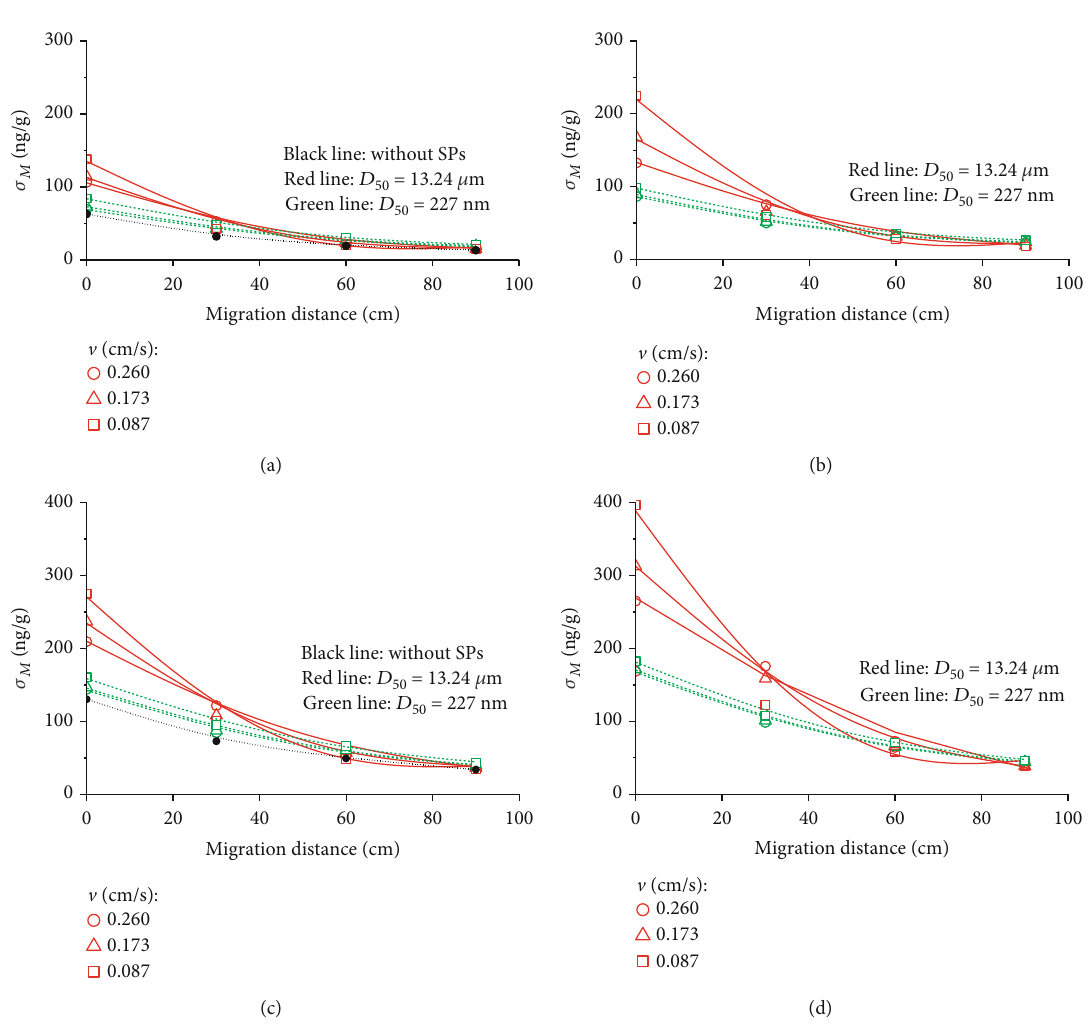
Figure 5: The deposition concentrations of copper ions along the transport distance: (a) C , C S = 2 mg/ml ; (c) C M = 400ng/ml , C S = 0 : 5mg/ml ; and (d) C M = 400ng/ml , C S = 2mg/ml